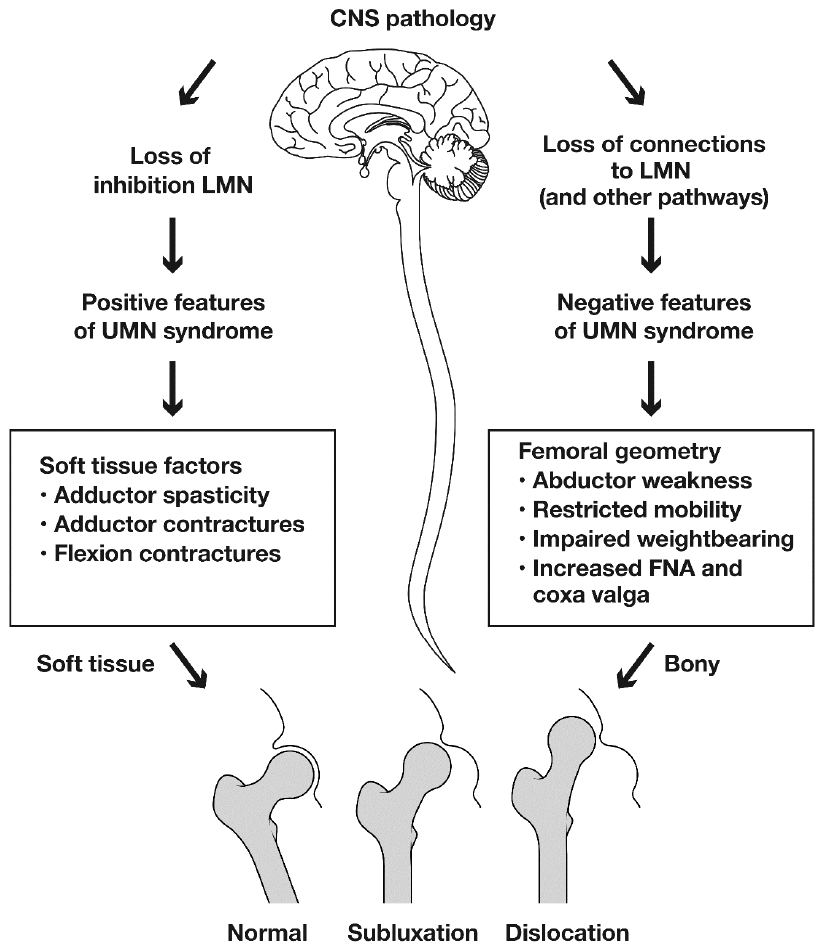
Figure 4. The pathophysiology of hip displacement in children with cerebral palsy. Copyright Bill Reid, Jason Howard and Kerr Graham, RCH Melbourne.